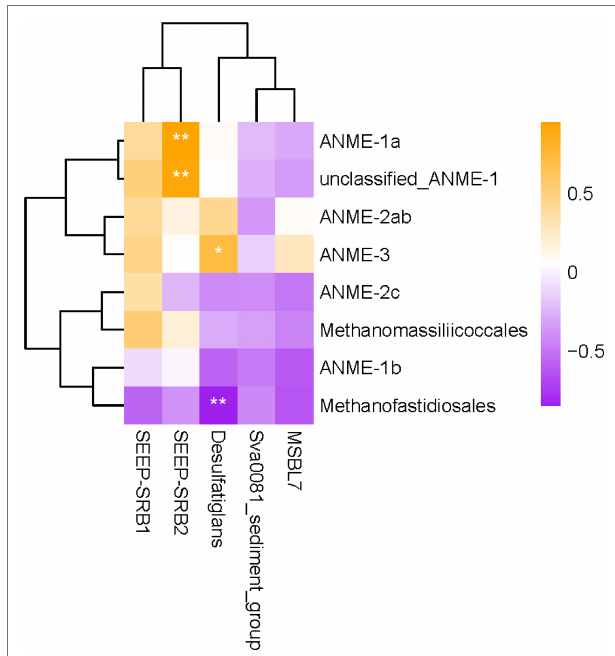
FIGURE 5 | Heatmap of Pearson’s correlation coefficients between methanogens/ANMEs and SRB. Correlation coefficients with p -value scores less than 0.05 and 0.01 are labeled with “*” and “**”,